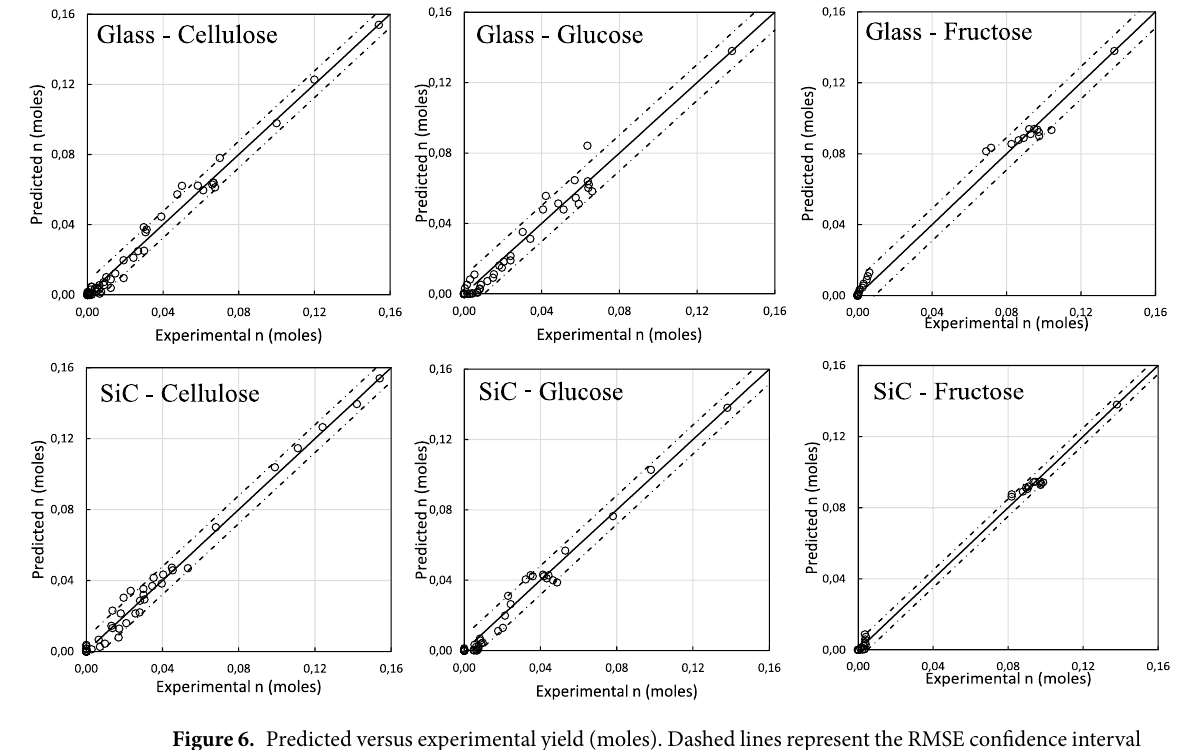
Figure 6. Predicted versus experimental yield (moles). Dashed lines represent the RMSE confidence interval (95%).